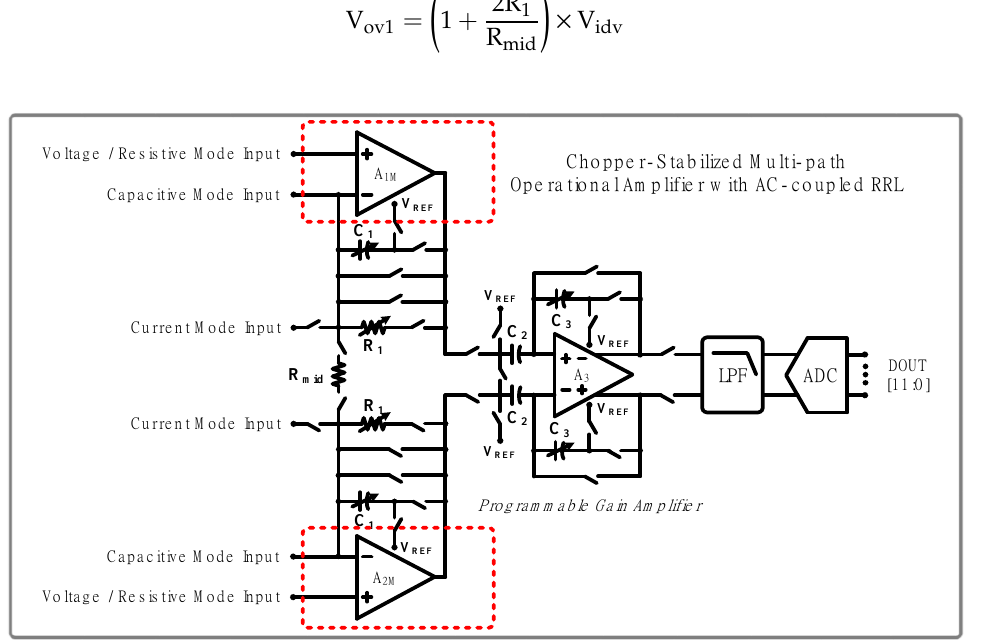
Figure 1. Block diagram of the proposed multimodal reconfigurable sensor readout circuit. ADC: analog-to-digital converter, LPF: low-pass filter.